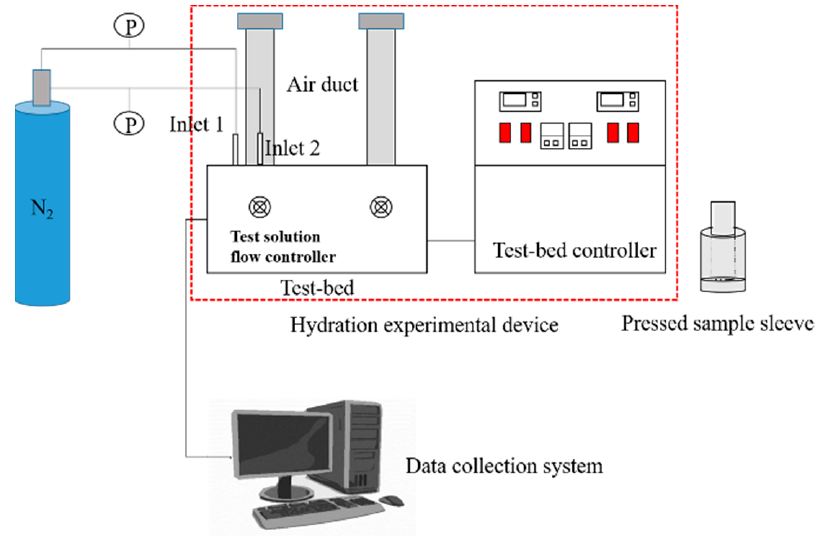
Figure 2. Hydration experimental device.